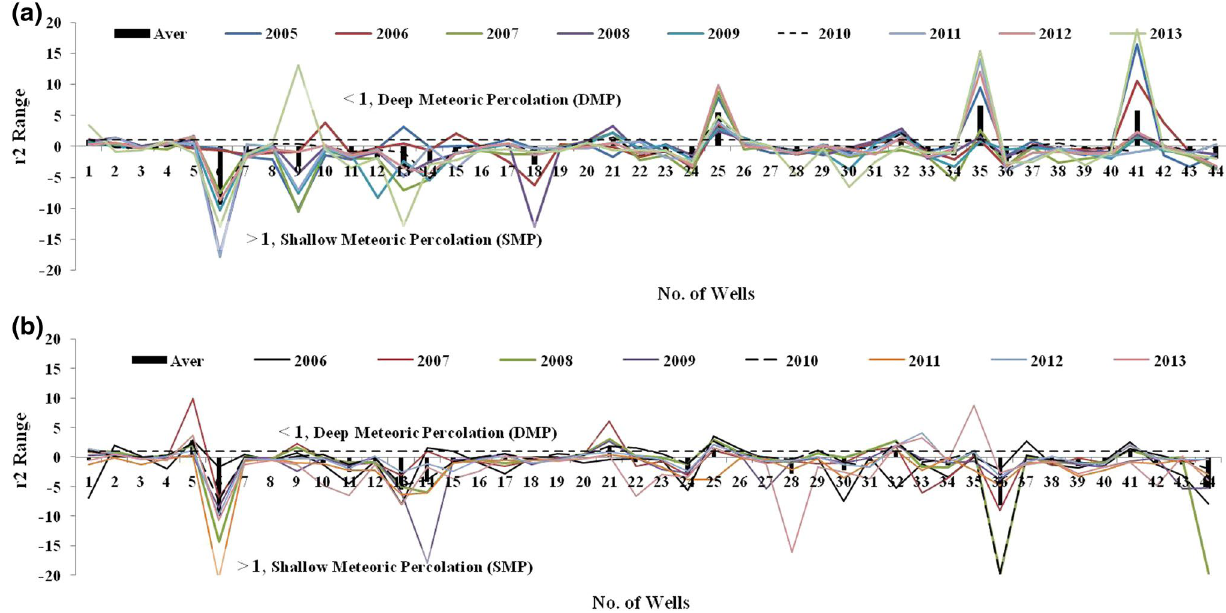
Fig. 15 a Nine-year (2005–2013) temporal representation r